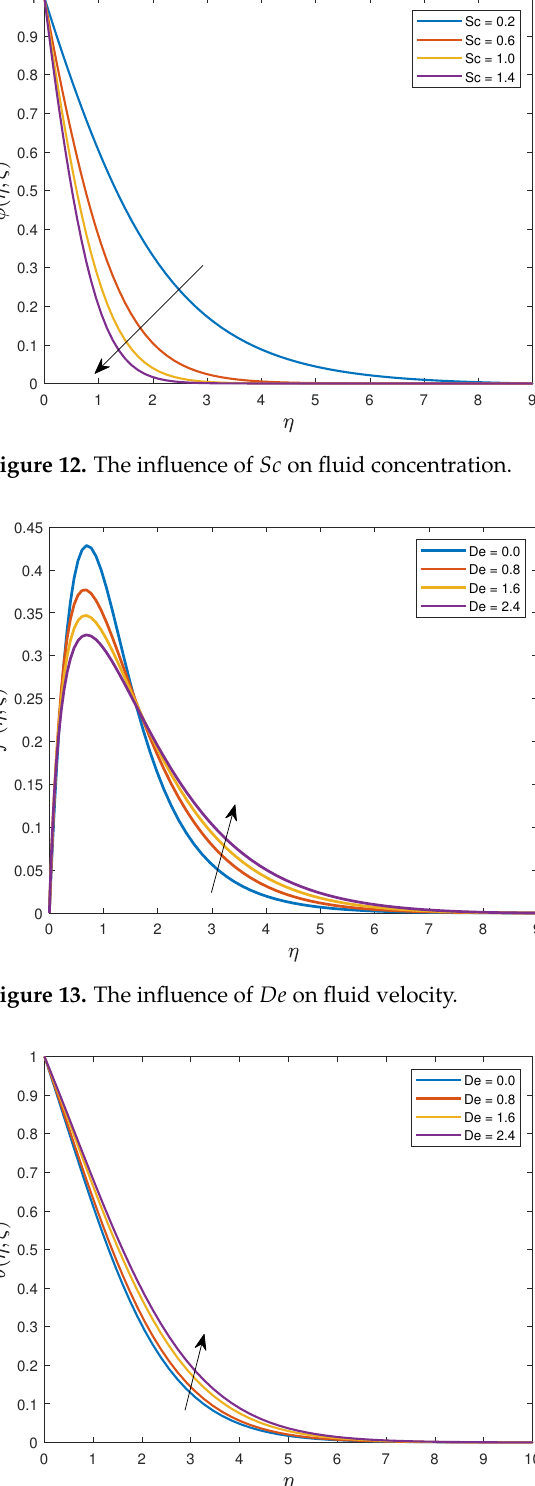
Figure 14. The influence of De on fluid